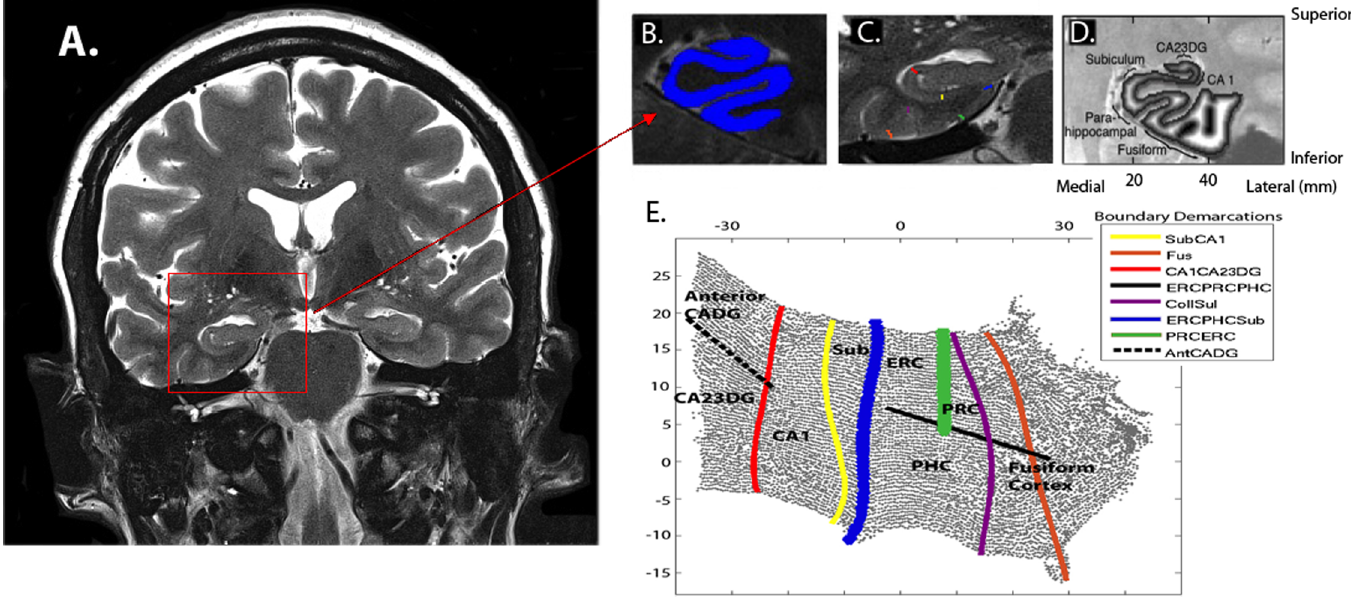
Fig 1. Methods for producing flat maps. Oblique coronal images are acquired to cover the long axis of the hippocampus as shown in image A . This image is cropped over the area of interest (red square) and shown in greater detail in image B . The gray matter ribbon (shown in bright blue) is segmented out from the surrounding MTL area. C . Boundaries between subregions are demarcated on each slice and projected to the corresponding location in flat-map space (shown in E). Boundaries between these subregions are shown in C and projected to flat-map (or 2D) space as shown in Fig E. D . Thickness in gray matter space is calculated in-plane space by taking the maximum distance value of the corresponding 3D voxels across all layers and multiplying by two to arrive at a thickness value for each voxel. E . The subregions are labeled as follows: cornu ammonis (CA) fields 1, 2, 3 and the dentate gyrus (DG) subiculum (Sub), entorhinal cortex (ERC), perirhinal cortex (PRC), parahippocampal cortex (PHC) and fusiform cortex (Fus). Boundary colors in C correspond to the same color scale in E and are labeled according to the Boundary Demarcation color bar.